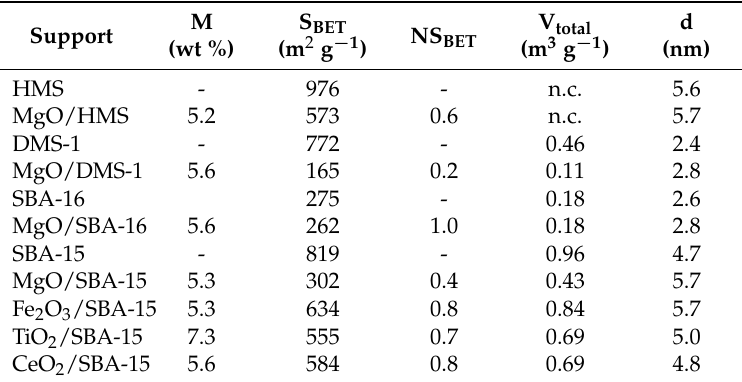
Table 1. Metal content a and textural b,c properties of the naked